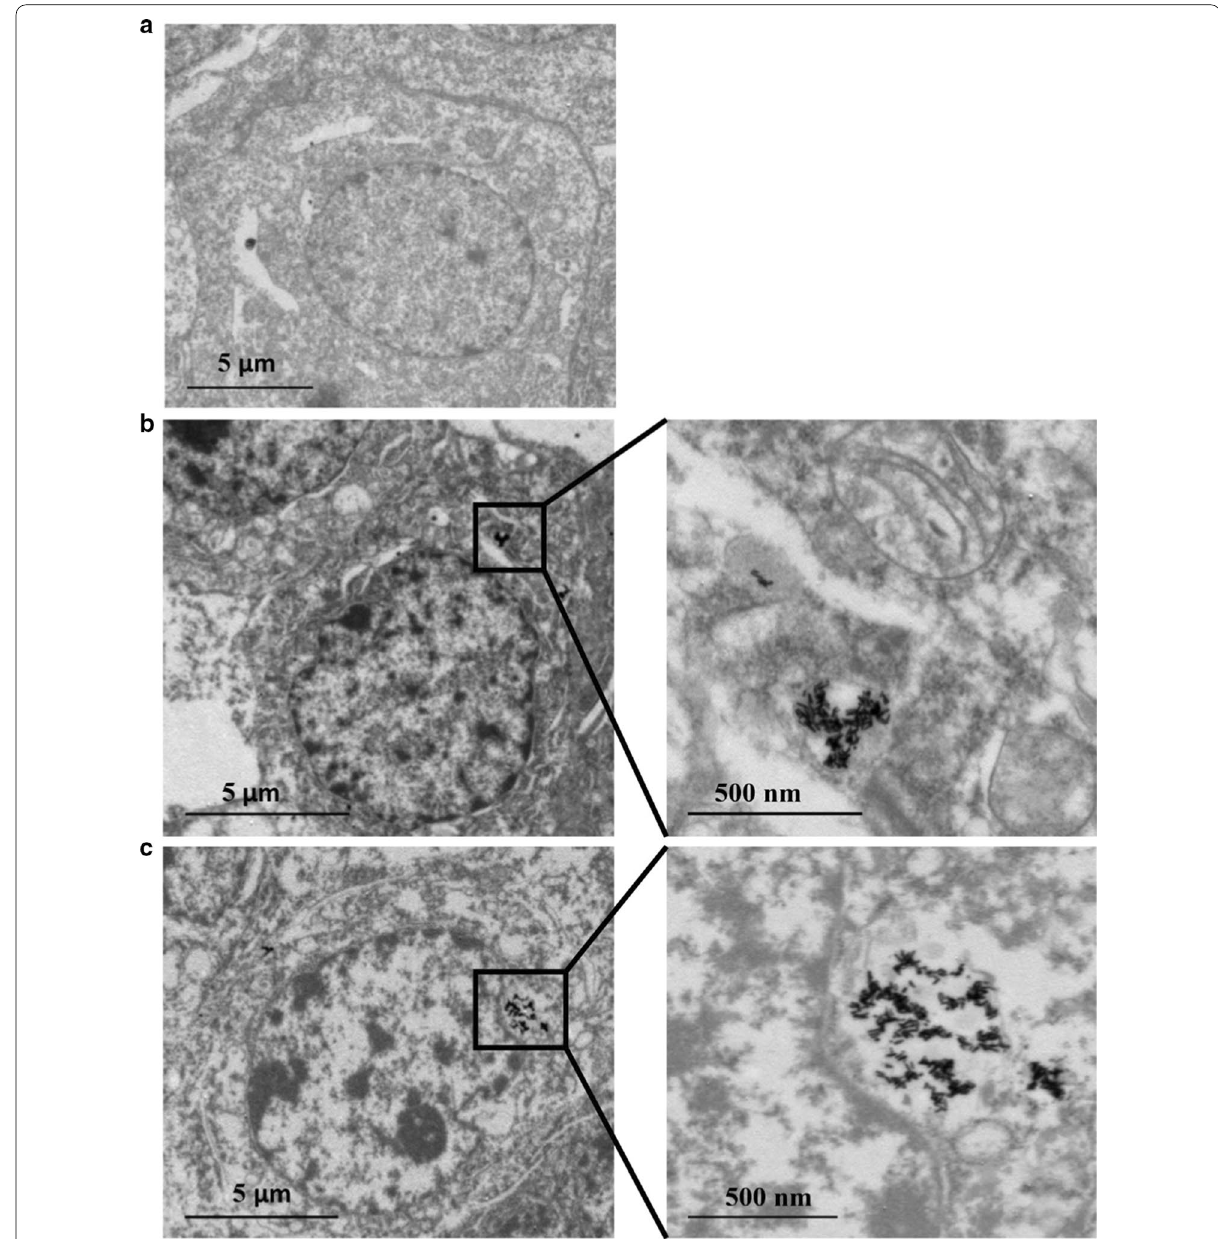
Fig. 2 Au NR and Au@Ag NR internalization: HepaRG by TEM at 80 kV after 24 h of exposure to 16 μg mL − 1 Au NR and 20 μg mL − 1 Au@Ag NR. a Vehicle control; b Au NR; c Au@Ag